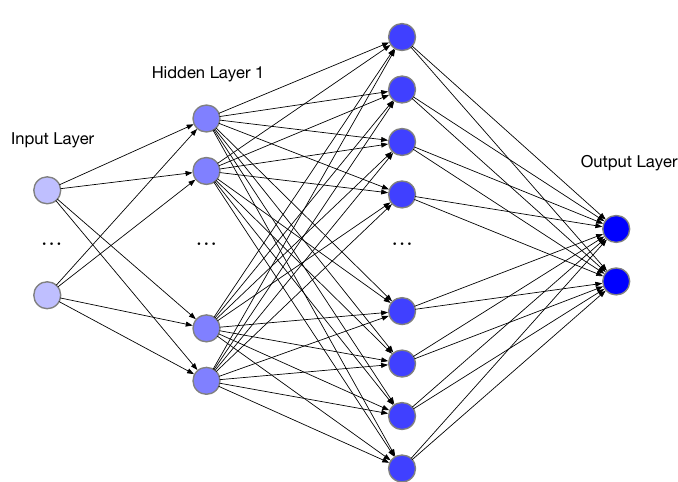
Figure 7. Artificial Neural